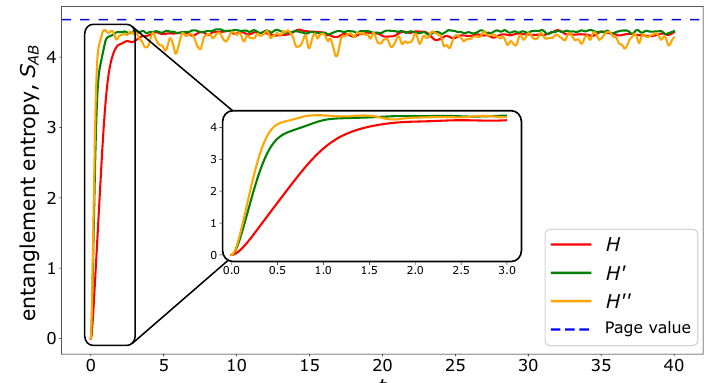
Figure 18: Growth of entanglement entropy S for an initial random state in S z -basis AB in the largest symmetry sector of the 5 × 5 lattice with p.b.c., for different interaction ≈ 4.36 (independent of the interaction range) ranges. S saturates to the value S AB AB ≈ 4.53, at a rate that increases below the Page value for this symmetry sector, S AB ,Page upon the increase of the interaction